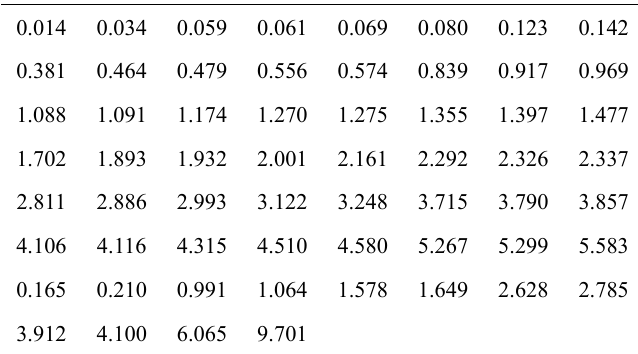
Failure times in 60 electrical appliances.